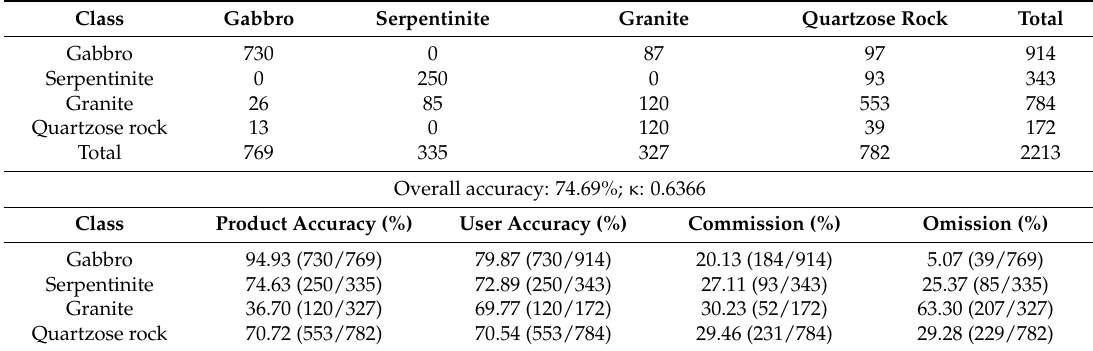
Table 4. Confusion matrix and accuracy evaluation of classification results using support vector machine (SVM) with seven spectral vectors.